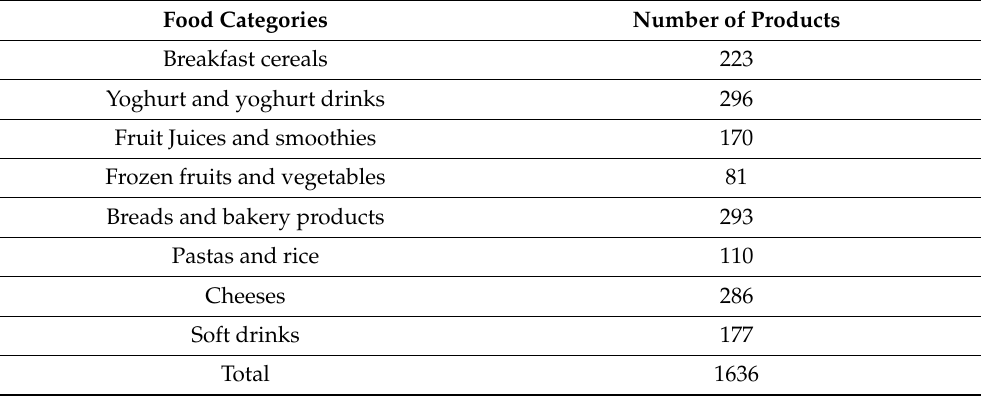
Table 3. Number of products per category.